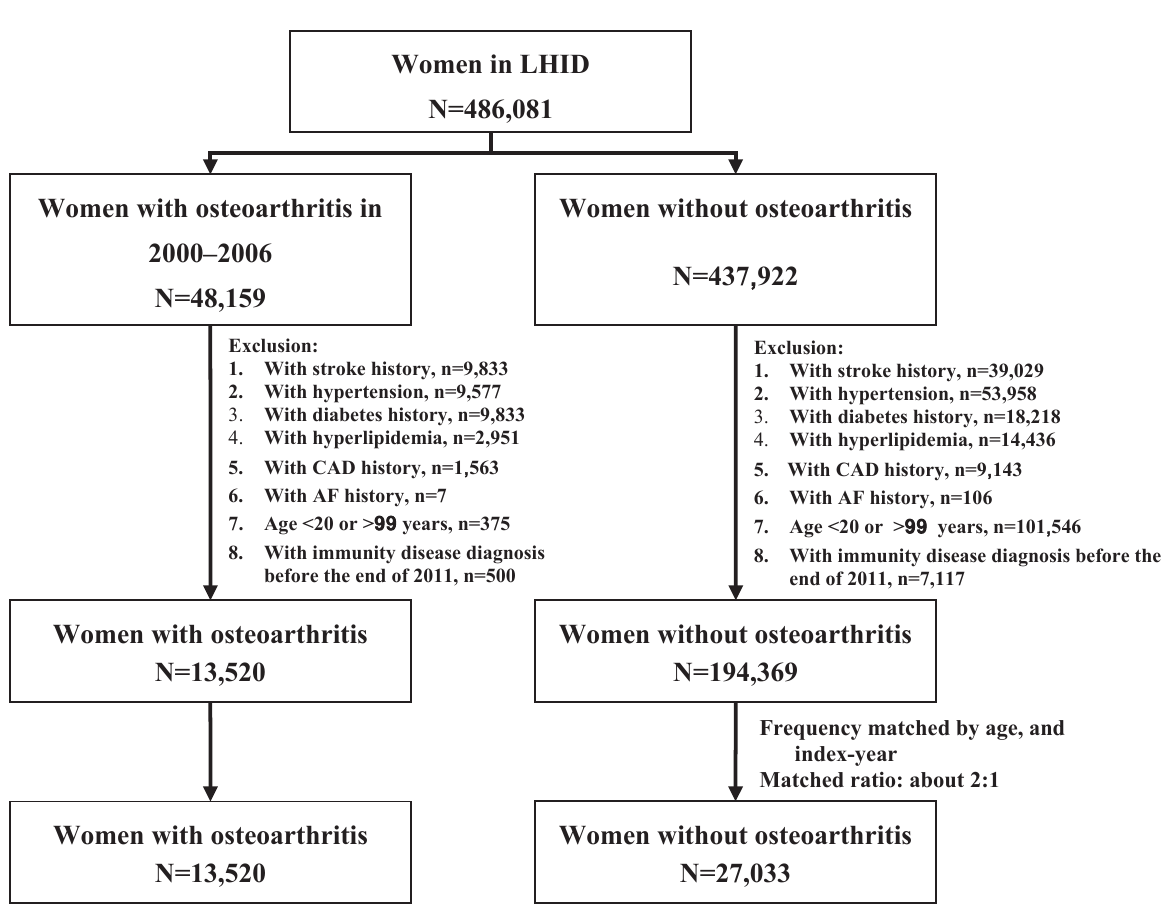
Figure 1. Flow chart of establishing the study cohorts